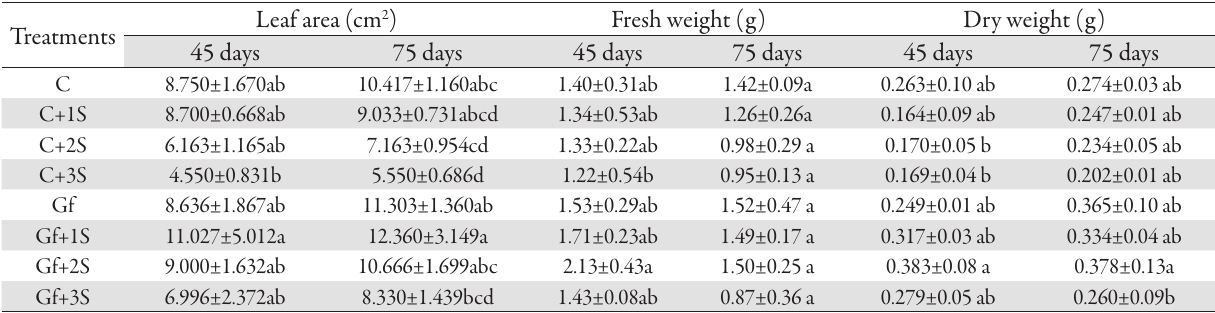
Tab. 1. Morphological parameters in Allium sativum L. after 45 and 75 days of AM treatment under non- salinity and salinity